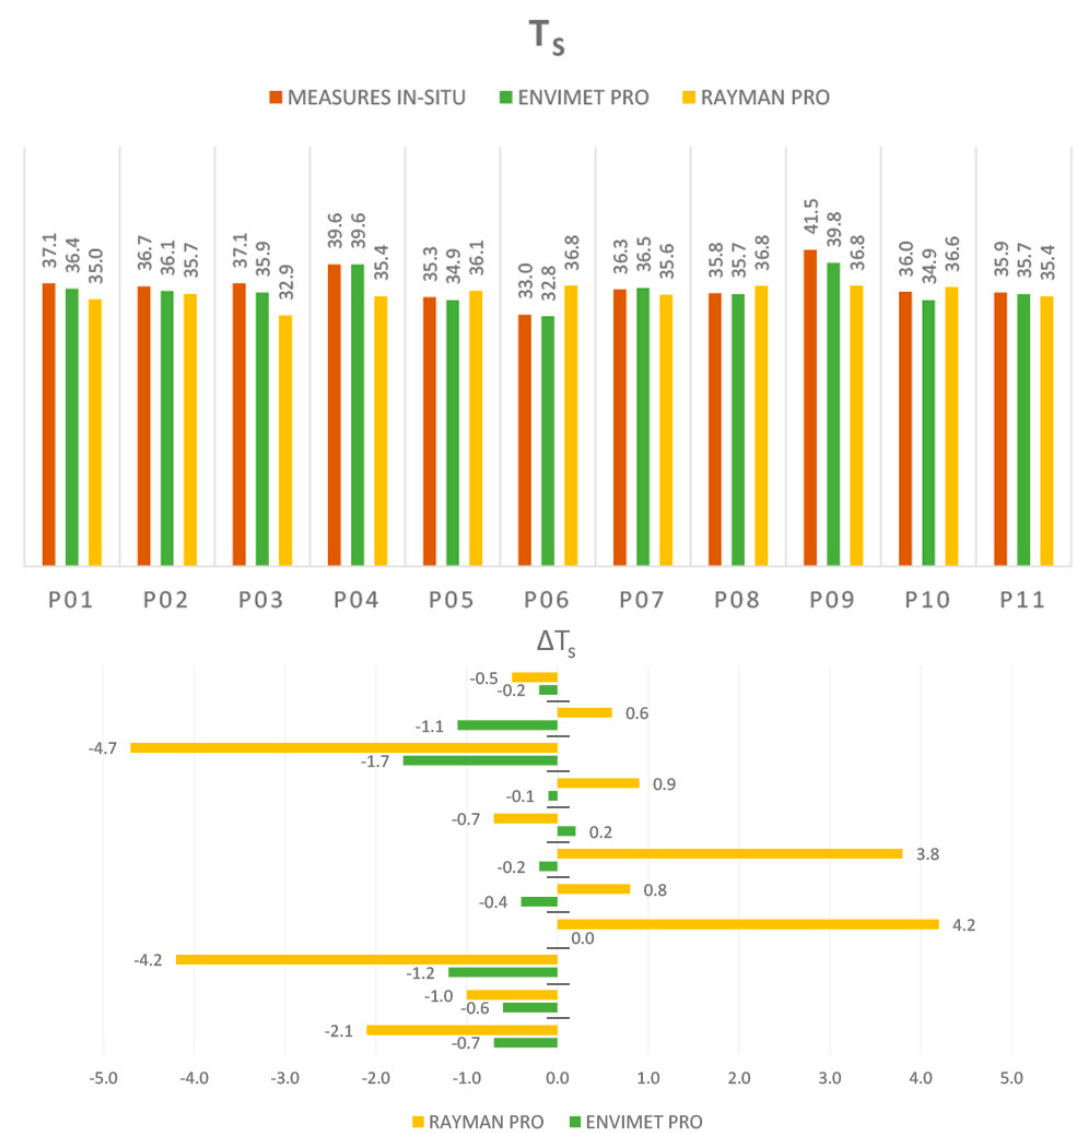
Figure 4. A comparison of the surface temperature value between the simulation results and the in-situ measurements, z = 0 m.